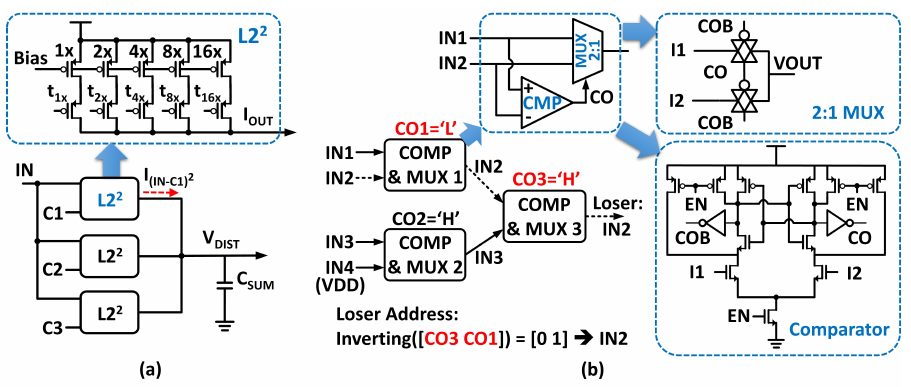
Figure 8. ( a ) Summation Unit for the proposed “Main Distance Computing Unit”; ( b ) Loser-Take-All (LTA) circuit based on cell-based tree structure and its inherent address decoding property (left), 2:1 multiplexer (right-top), and comparator (right-bottom) used for LTA unit.